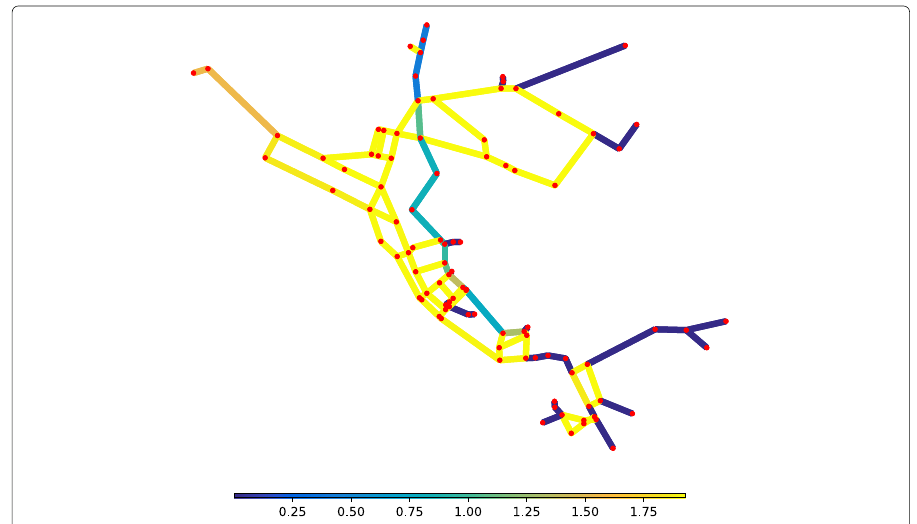
Fig. 3 Reserve capacity of Net3 links. A hydraulic CLA is carried out to measure the reserve capacity of Net3 associated with the individual failure of each link. Reserve capacity measures the fraction of the total demand the network can supply while meeting pressure requirements. The darker the link, the more critical